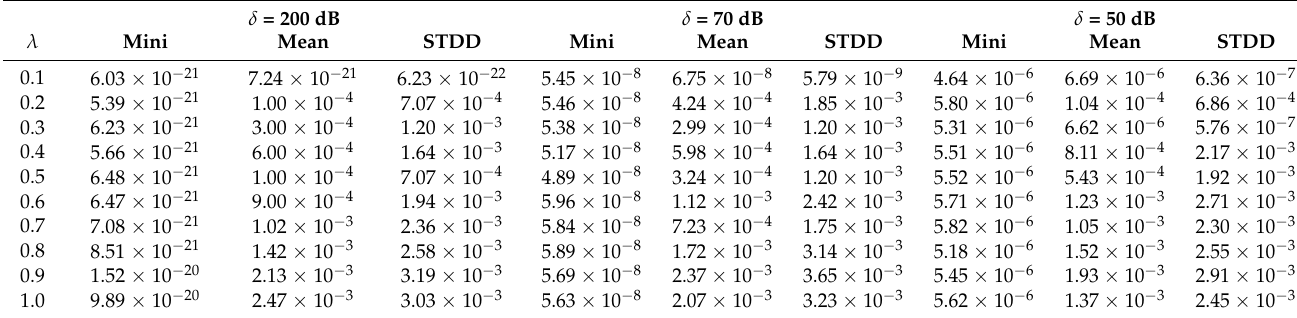
Table 4. Values of statistical indices through Monte Carlo